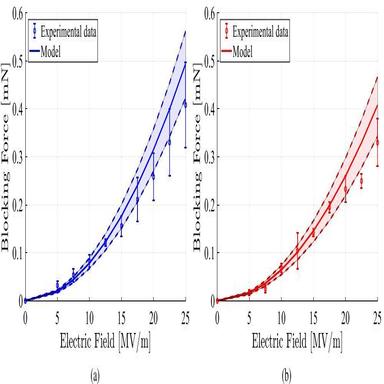
Experimental and model blocking forces for (a) transversally aligned nanofibers integrated in PDMS (b) longitudinally aligned nanofibers integrated in PDMS. The shaded areas represent the simulation results with the relative permittivity values spanned between 9 and 12.